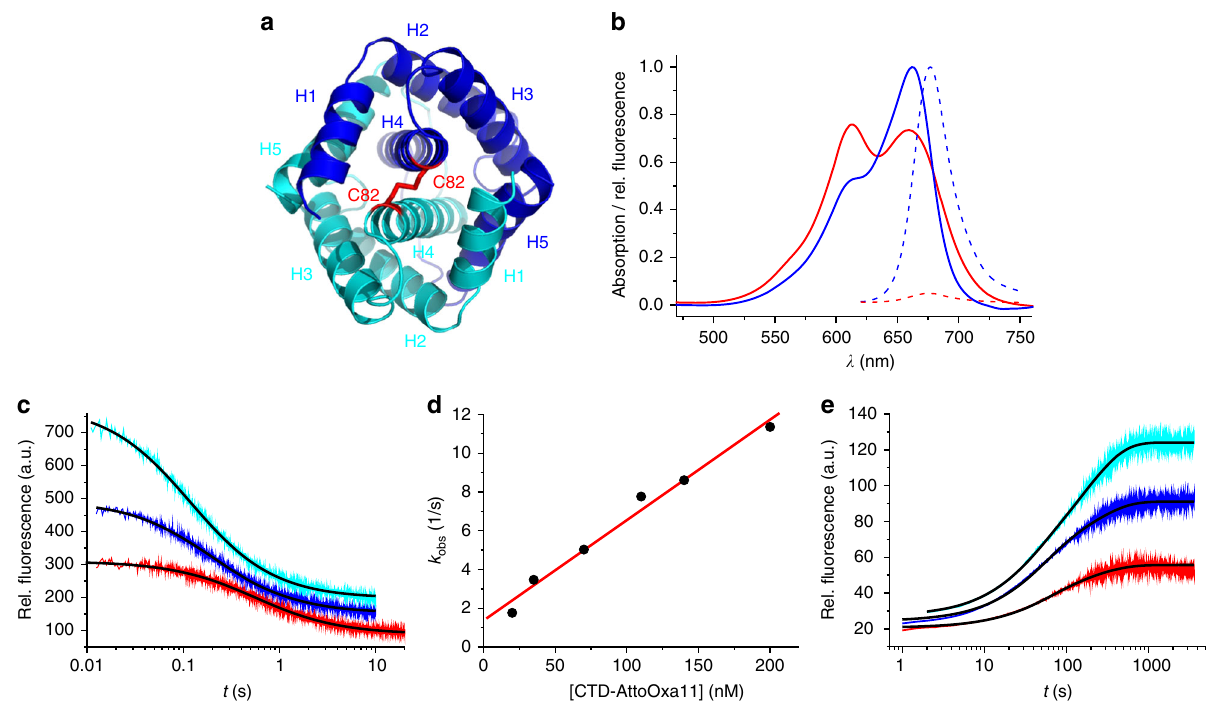
Fig. 4 Kinetics of dimer formation and dissociation. a Top view on the homology model of the CTD shown in cartoon representation. The two subunits constituting the dimer are shown in blue and cyan. Helices 1 – 5 are indicated. The intermolecular disul fi de formed by side chain C82, which was used for fl uorescence modi fi cation, is highlighted in red stick representation. Unfolded N-terminal tails are omitted for reasons of clarity. b Steady-state absorption (solid lines) and fl uorescence emission (broken lines) spectra of native dimeric (red) and chemically denatured monomeric (blue) CTD-AttoOxa11. c Kinetic transients of CTD dimerization measured by refolding chemically denatured CTD-AttoOxa11 using stopped- fl ow fl uorescence spectroscopy. Representative transients of 20 (red), 70 (blue), and 140 nM (cyan) CTD-AttoOxa11 are shown. Transients are offset along the y -axis for reasons of clarity. Black lines are fi ts to a kinetic model of dimerization. d Observed rate constants of dimerization plotted versus concentration of CTD-AttoOxa11. The red line is a linear fi t to the data. e Kinetic transients of CTD dissociation measured by chasing 60 (red), 120 (blue), and 180 nM (cyan) CTD-AttoOxa11 with 20 µ M chemically reduced wild-type CTD. Transients are offset along the y -axis for reasons of clarity. Black lines are fi ts to the data using a bi-exponential